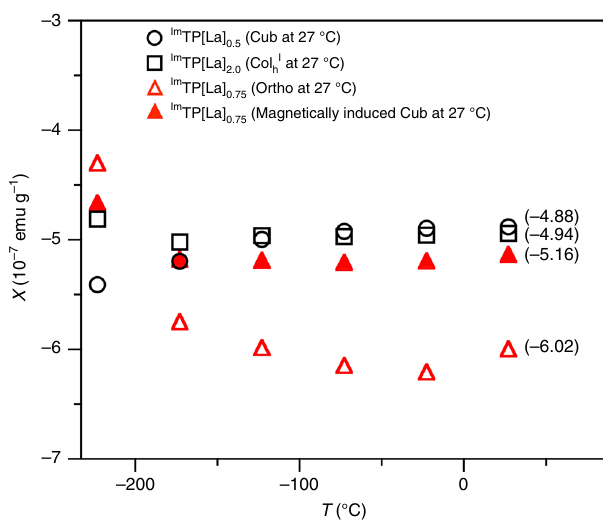
Fig. 4 SQUID measurements of Im TP[La] x . χ − T curves for Im TP[La] x after thermal processing in the absence of a magnetic fi eld ( x = 0.5: open circle, x = 2.0: open square and x = 0.75: open triangle) and for Im TP[La] thermal processing in a 10-T magnetic fi eld ( fi lled triangle). Values in parentheses represent the χ values (10 − 7 emu/g) of the samples at 27